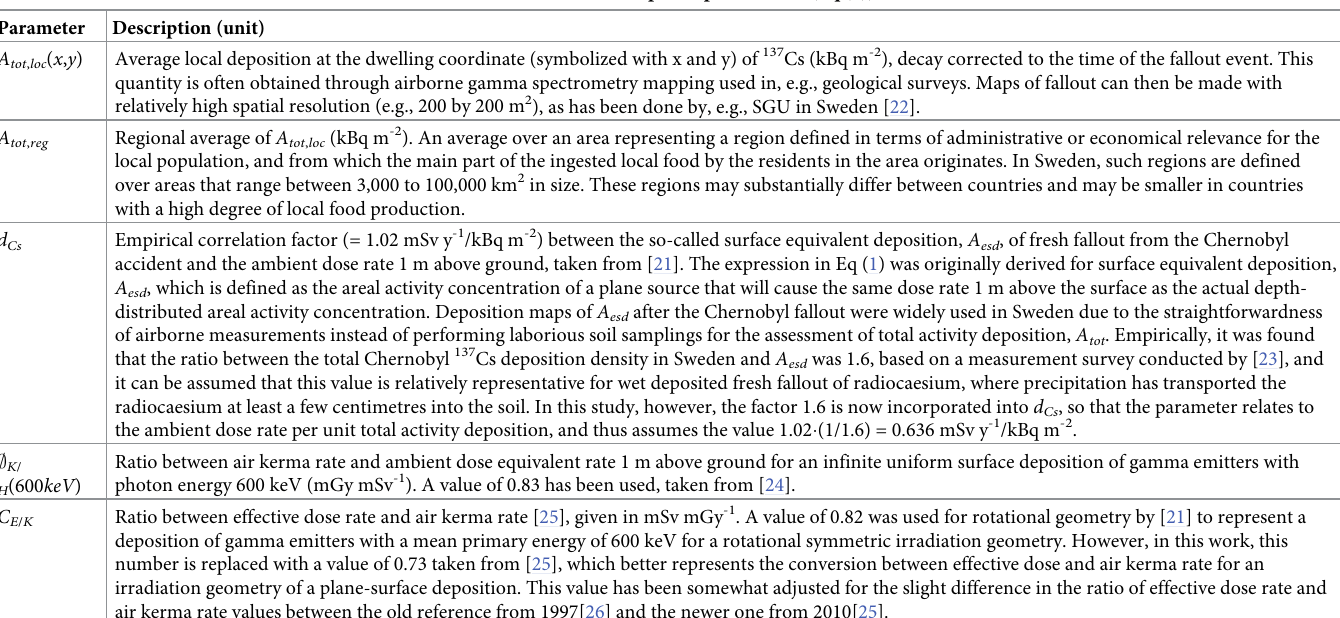
Table 1. Parameter values used for calculation of effective dose from a nuclear power plant fallout (Eq (1)). Parameter Description (unit) A tot , loc ( x , y